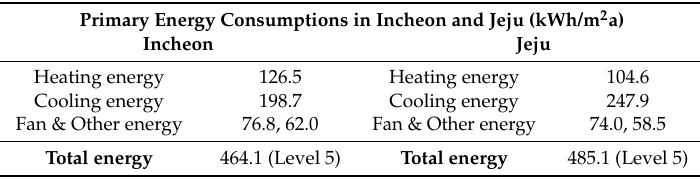
Table 7. Primary energy consumption in Incheon and Jeju (Base model).